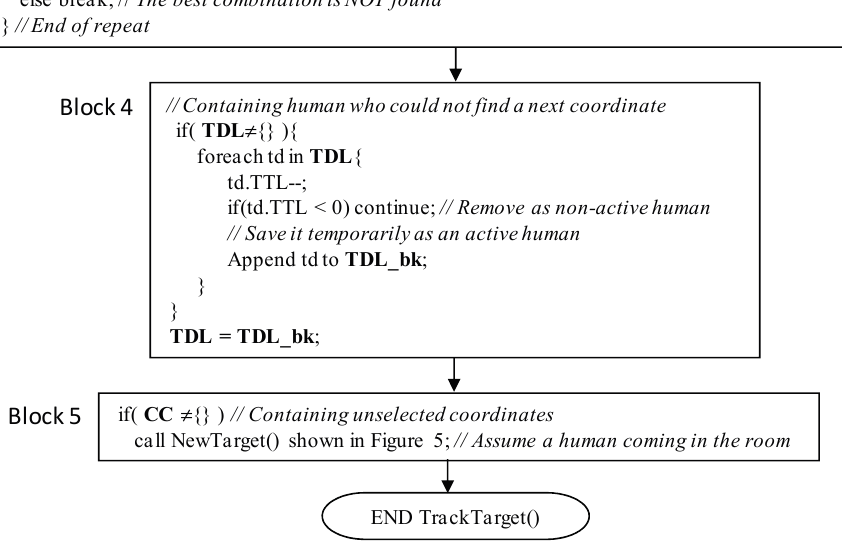
Figure 6. Procedure to estimate the next position of each